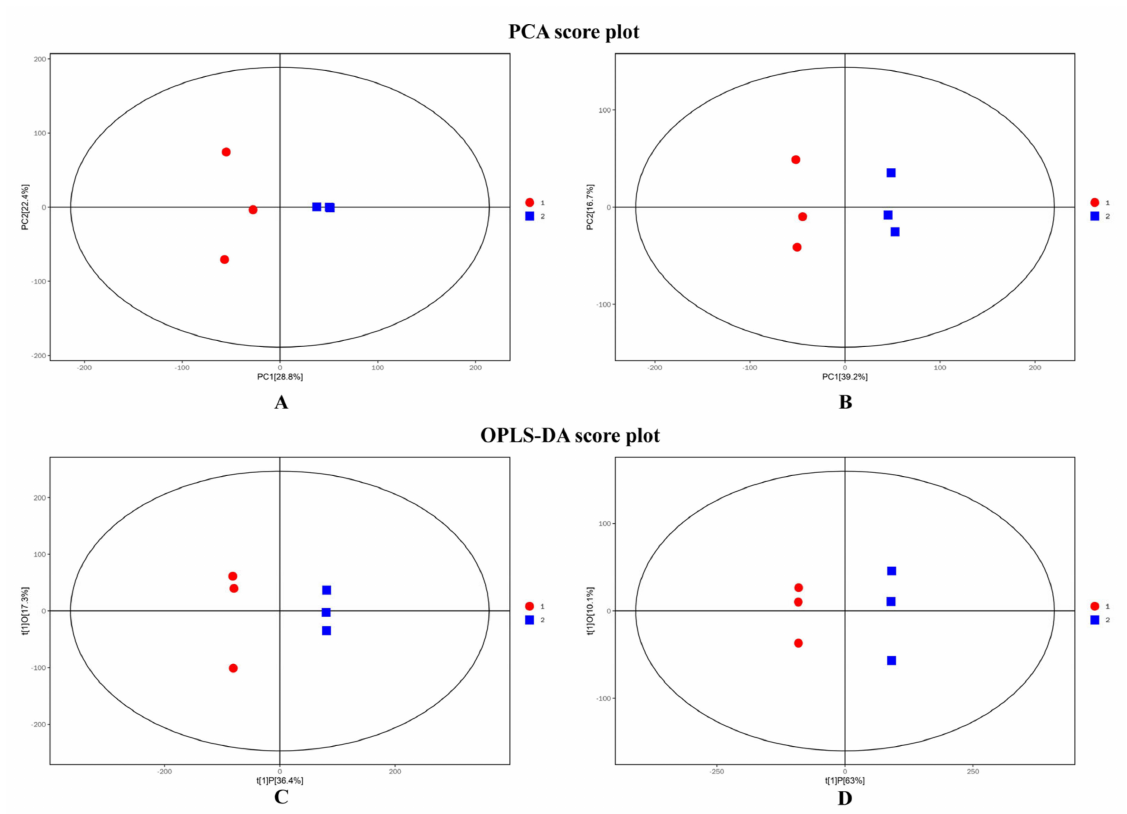
Figure 2. PCA and OPLS-DA score plots of the samples before and after fermentation ( n = 3). Remarks: 1, red circle (LL); 2, blue square (FLL). ( A ) PCA score plot in positive-ion mode; ( B ) PCA score plot in negative-ion mode; ( C ) OPLS-DA score plot in positive-ion mode; ( D ) Score plot of OPLS-DA in negative-ion